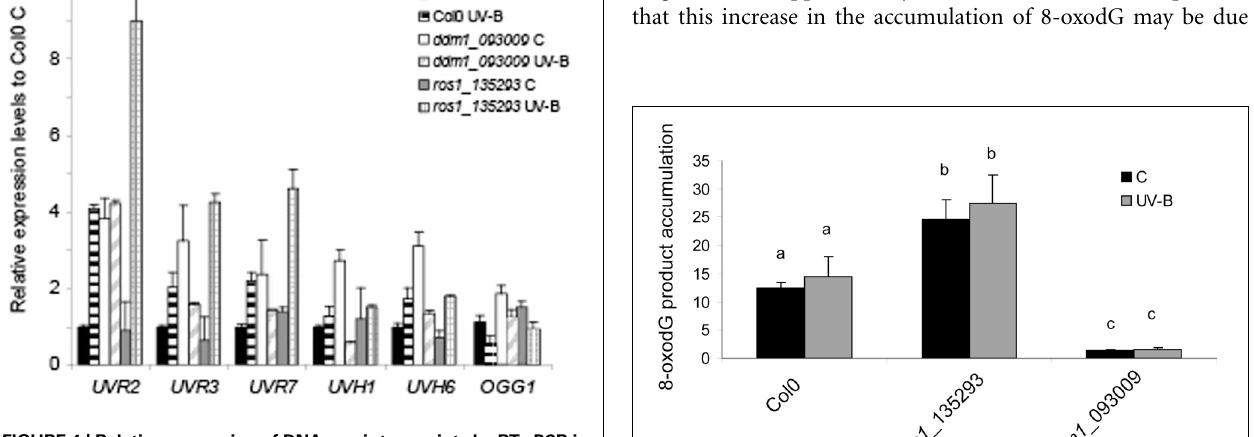
FIGURE 4 | Relative expression of DNA repair transcripts by RT-qPCR in Col0, ddm1 ( ddm1_093009 line) and ros1 ( ros1_135293 line). Levels of UVR2, UVR3, UVR7, UVH1, UVH6, and OGG1 were assayed in arabidopsis plants that were irradiated with UV-B for 4h (UV-B) or were kept under control conditions without UV-B (control, C). Expression values are relative to the values in Col0 plants under control conditions in the absence of UV-B. The CPK3 transcript was used as a control. Data show mean values ± S.E.M. of at least three independent experiments.